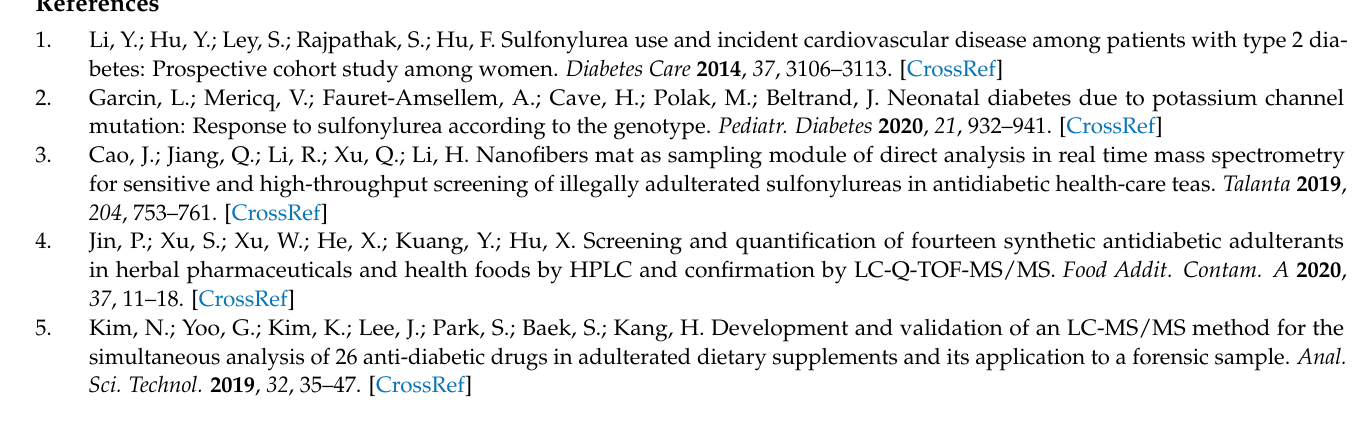
Table S2: The optimal MS/MS parameters for the detection of SUs; Table S3: Cross-reactivity